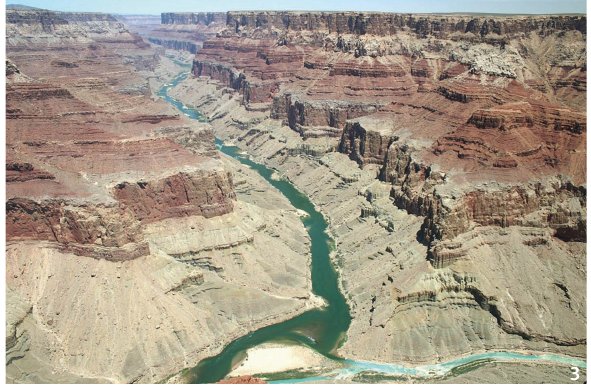
Figure 3 View of the Colorado River flowing through Grand Canyon National Park (Source: National Park